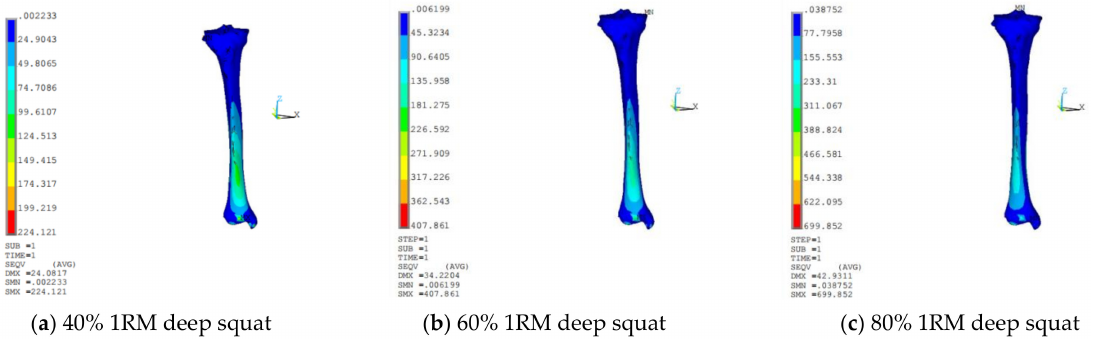
Figure 10. Cloud chart of tibia stress distribution of deep squat.